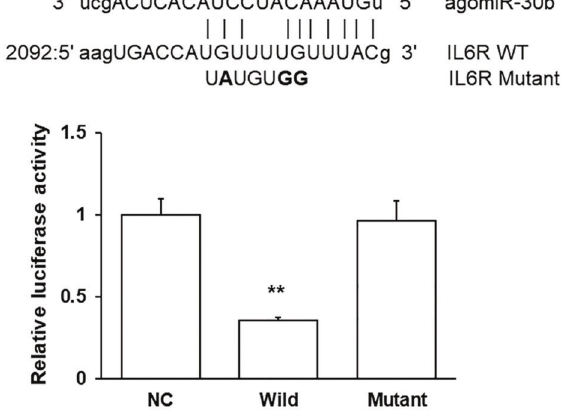
Figure 4. IL-6R is a possible target of miR-30b. The wildtype (WT) and mutant Il-6r 3 0 UTR luciferase reporter constructs were co-transfected with negative control RNA (NC) or agomiR-30b, respectively. Luciferase activities were assayed 24 h post trans- fection. Data are reported as means ± SD. **P o 0.01, compared with NC (one-way